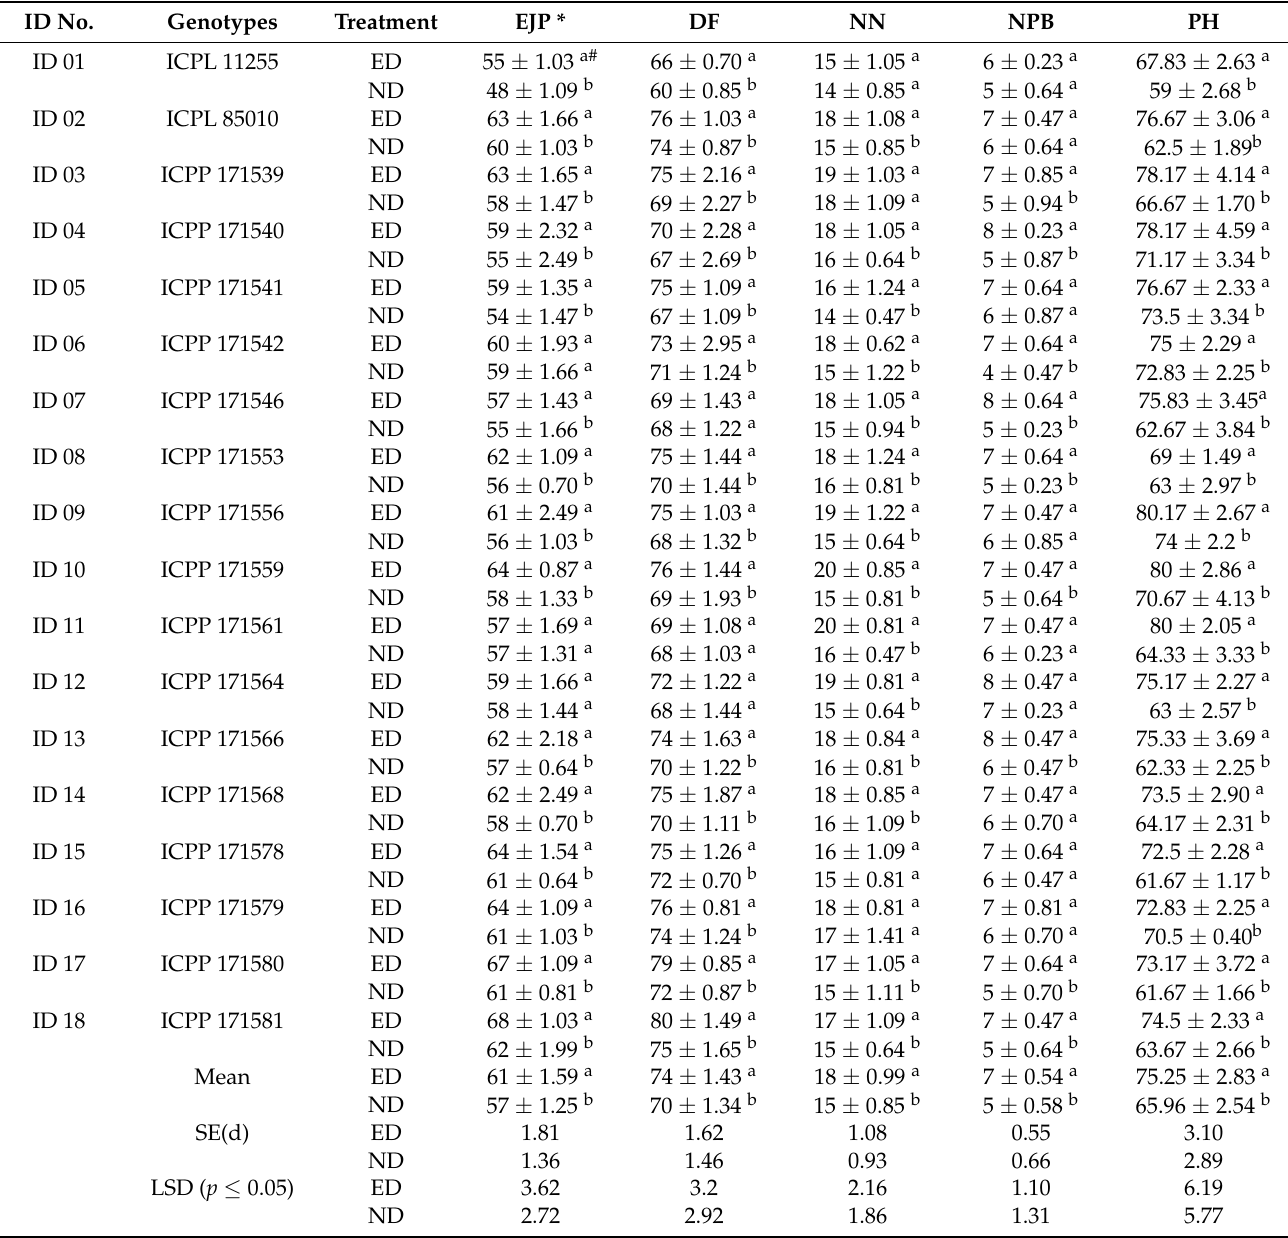
Table 2. Pooled mean comparison showing the effect of a photoperiod on photoperiod-sensitive traits in extra-early flowering pigeonpea introgression lines at ICRISAT, Patancheru, India. ID